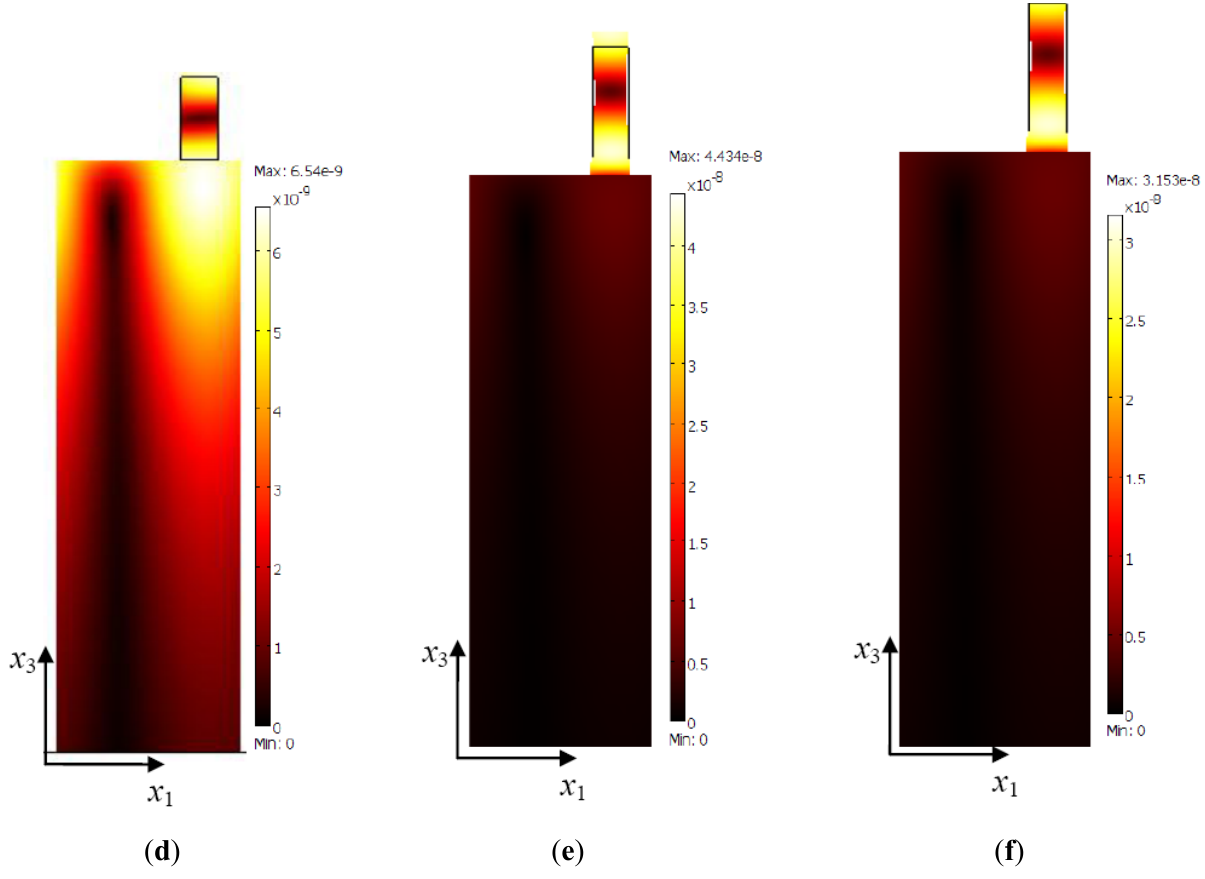
at the SAW resonator surface (at x = 0 x 3 3